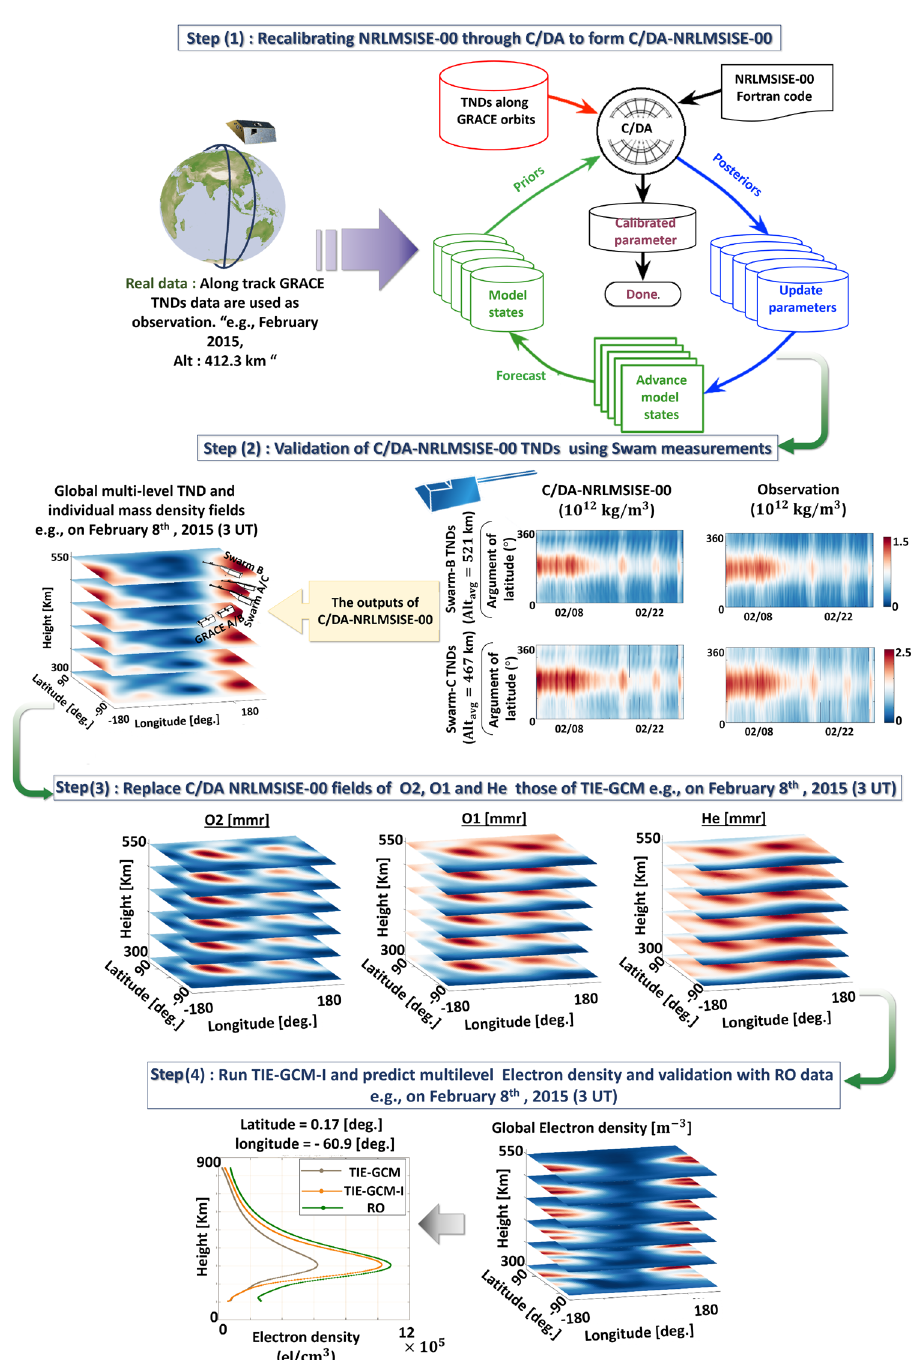
Figure 3. An overview of the proposed C/DA procedure and validation experiments. The procedure is divided into four steps: (1) Applying the C/DA on the NRLMSISE-00 model to form C/DA-NRLMSISE-00, (2) Validating TNDs against Swarm measurements, (3) Improving the primary history files of TIE-GCM using the forecasting values provided by C/DA-NRLMSISE-00, and (4) validating the ionospheric variables using GNSS and RO measurements. The plots were generated using MATLAB (version R2021a, https:// www. mathw orks. com/) and PowerPoint (2016, https:// www. micro soft. com/) was used for producing the